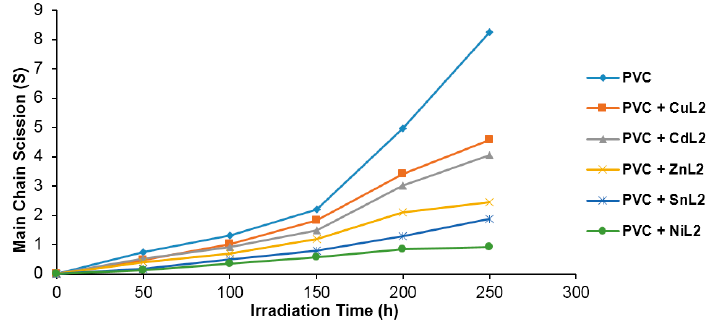
Figure 8. Effect of irradiation time (250 h) on S for PVC films (40 μ m thickness) containing ML 2 (0.5 wt %).